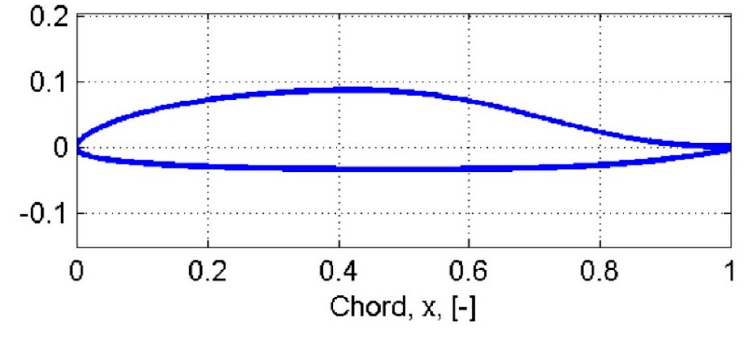
Figure 1. Roncz Airfoil [22].